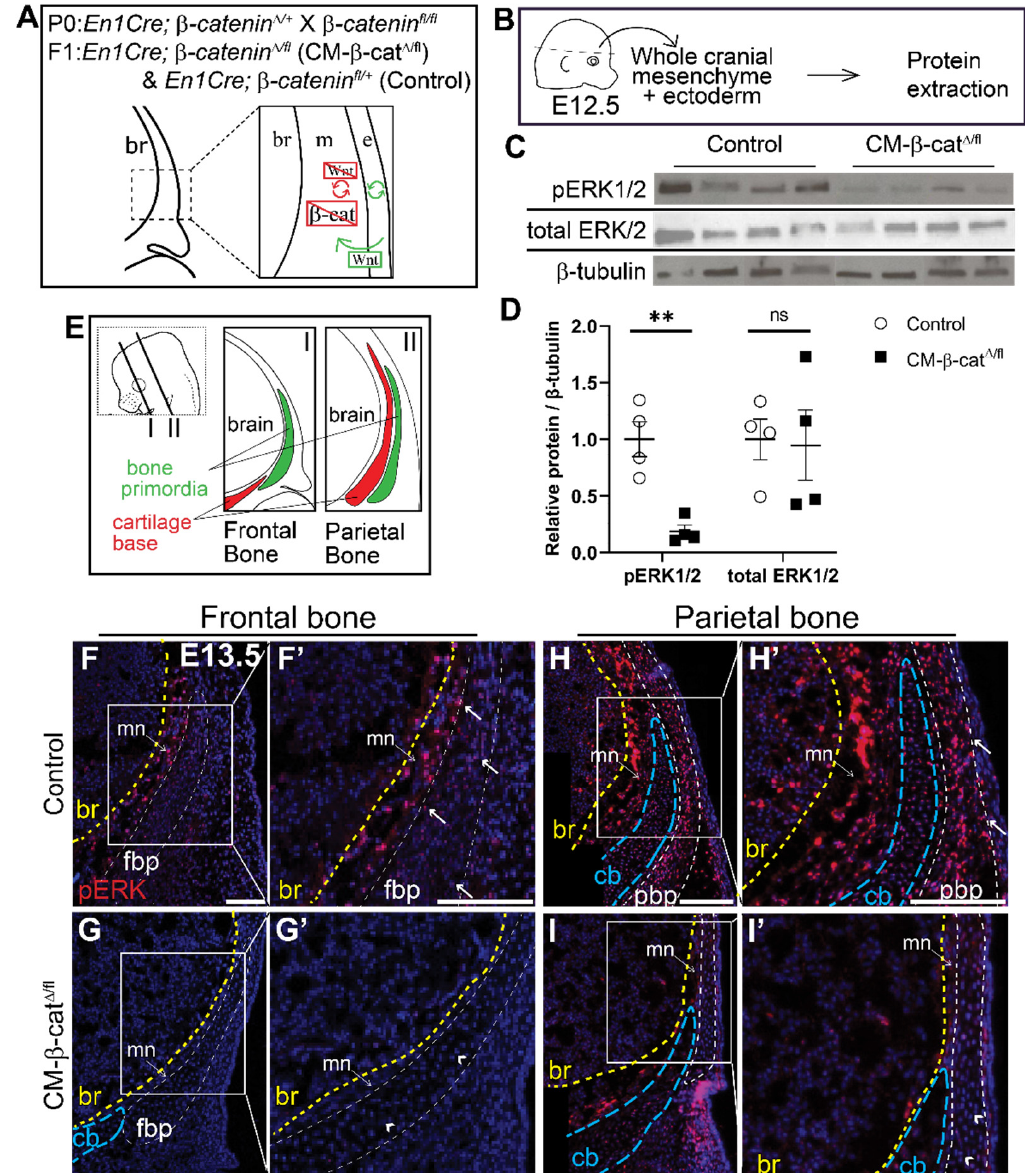
Figure 3. ERK signaling is diminished in CM- β -cat ∆ /fl mutants. ( A ) Schematic depicting the status of Wnt signaling in the cranial mesenchyme and overlying ectoderm in this mouse model of Wnt signaling deletion. br, brain; m, mesenchyme; e, ectoderm. β -catenin is deleted in the cranial mesenchyme preventing mesenchyme Wnt signaling. The ectoderm is able to secrete Wnt ligands and undergo Wnt signaling. ( B ) Schematic depicting the work flow and tissue source for the protein analysis in panels C and D. ( C , D ) Expression of activated ERK1/2 (pERK1/2) and total ERK1/2 relative to β -tubulin expression in En1Cre; β -catenin fl/+ (control) and En1Cre; β -catenin ∆ /fl (CM- β -cat ∆ /fl ) normalized to control. p (**) = 0.0026 ( E ) Schematic indicating the plane and orientation of specimens. ( F – I’ ) Immunofluorescence staining of pERK1/2 in control and CM- β -cat ∆ /fl coronal sections at E13.5 in the frontal ( F – G’ ) and parietal bone regions ( H – I’ ). Yellow lines demarcate the br, brain; blue lines demarcate the cb, cartilage base; mn, meninges. Arrows denote pERK1/2 signal in the bone primordia of the controls and arrowheads denote lack of signal in the CM- β -cat ∆ /fl . fpb, frontal bone primordia; pbp, parietal bone primordia; n = 4